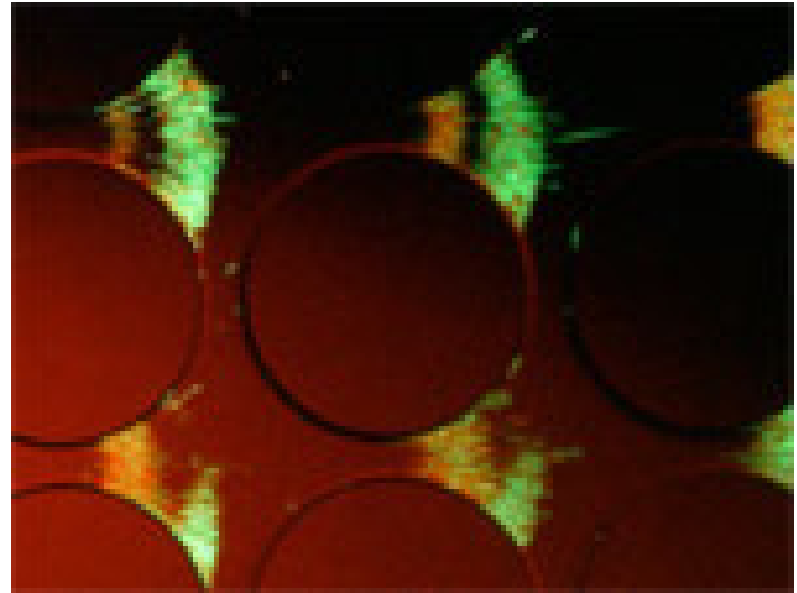
Figure 6. Electric field gradients created between microfabricated posts separate fluorescently tagged live and dead E. coli while dielectrophoretically concentrating them in